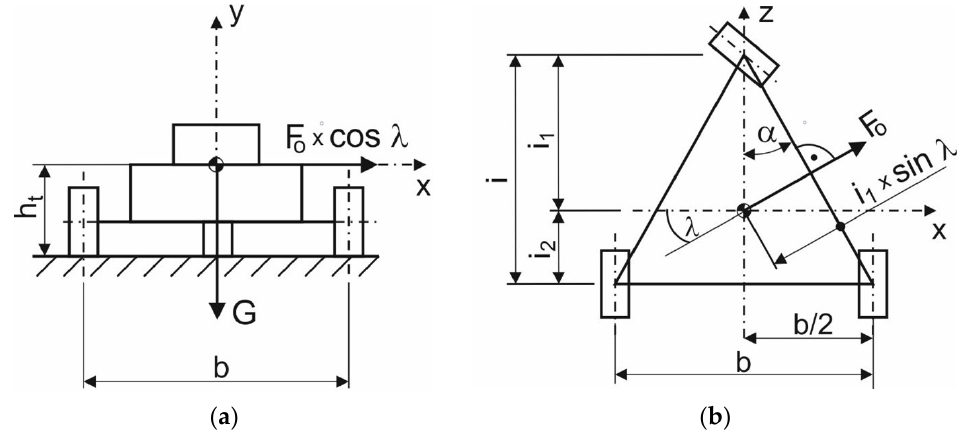
Figure 9. A calculation schema of a conventional tricycle: ( a ) Back view; ( b ) Top